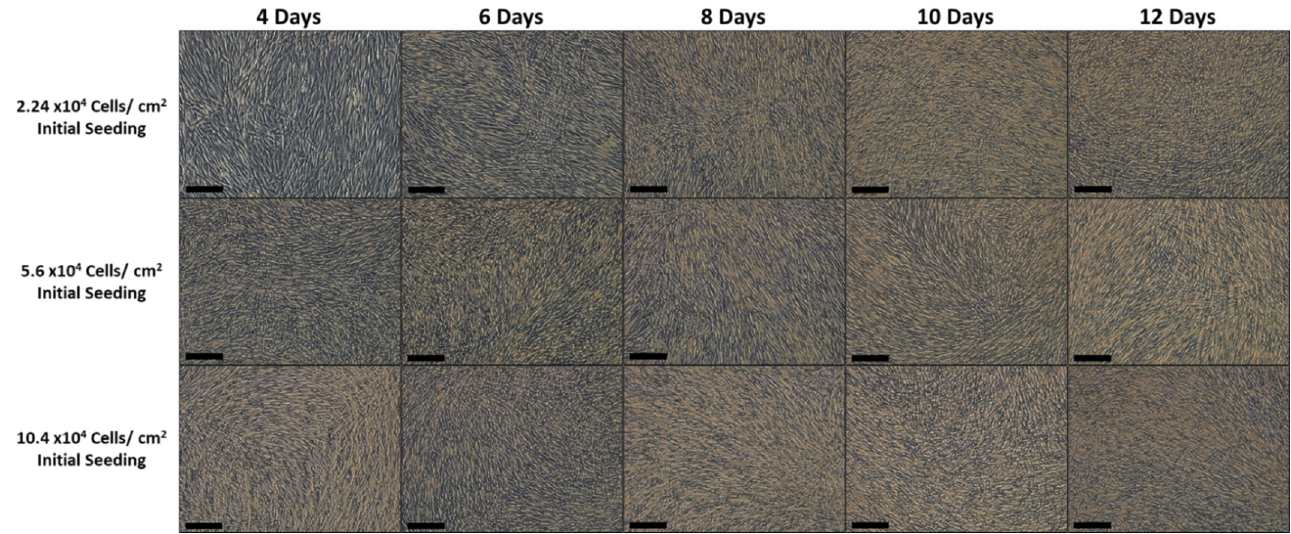
Figure 2. Picture showing the changes in the cell sheet morphology over time, up to 12 days, with 3 different initial ASC seeding. Notice the change of the ASC from a fibroblastic shape to a round shape (Scale bars are 200 μ m).